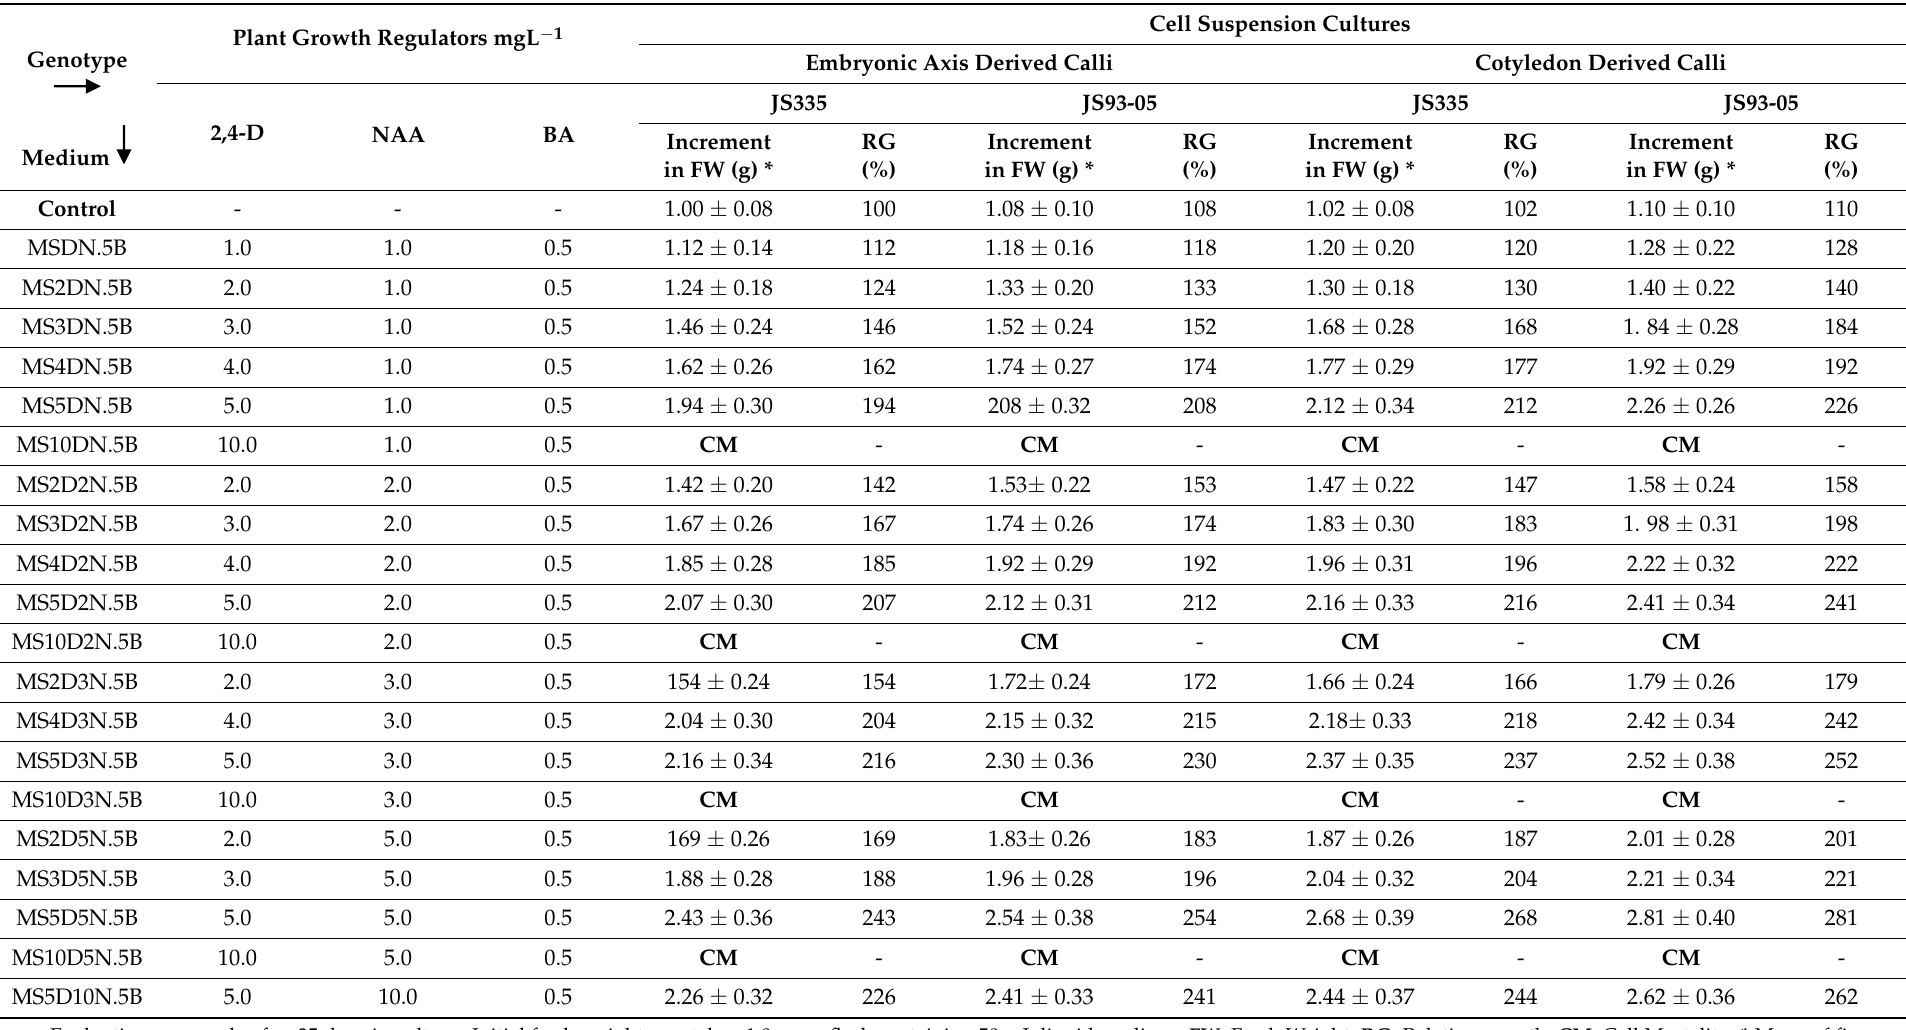
Table 2. Combined effects of added cytokinins and auxins in varying concentrations and combinations on proliferation of embryogenic cell suspension cultures.